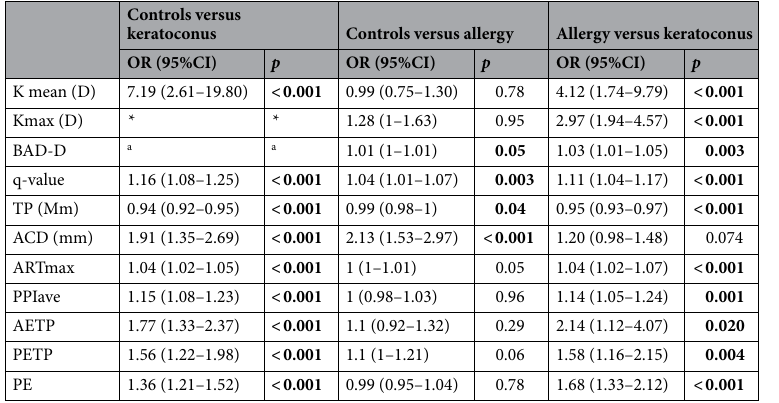
Table 3. Multivariate logistic regression models applied to topographical parameters adjusted for age and sex in comparisons between pediatric keratoconus patients, pediatric ocular allergy patients, and healthy controls. Boldface indicates statistical significance ( p < 0.05). K1 flat keratometry, K2 steep keratometry, Kmax maximum keratometry, Astig astigmatism in Sim K, TP thinnest pachymetry, ACD anterior chamber depth, BAD-D Belin/Ambrosio enhanced ectasia display, ARTmax Ambrosio’s relational thickness maximum, PPIave average pachymetric progression index, AETP anterior elevation at the thinnest point, PETP posterior elevation at the thinnest point, PE maximum posterior elevation. *K maximum > 47.1 predicts data perfectly. a BAD-D > 2.42 predicts data